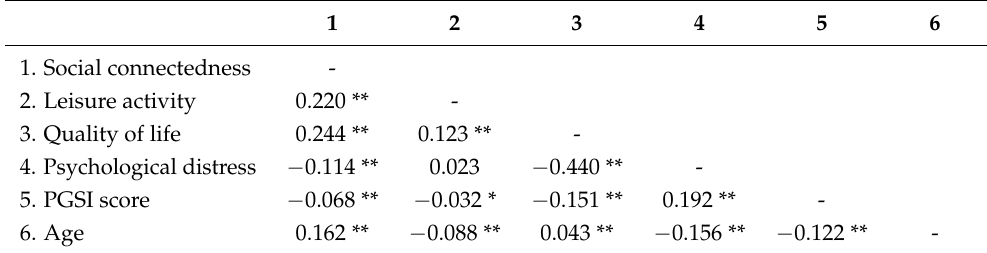
Table 2. Spearman’s correlations of social connectedness, leisure activity, quality of life and